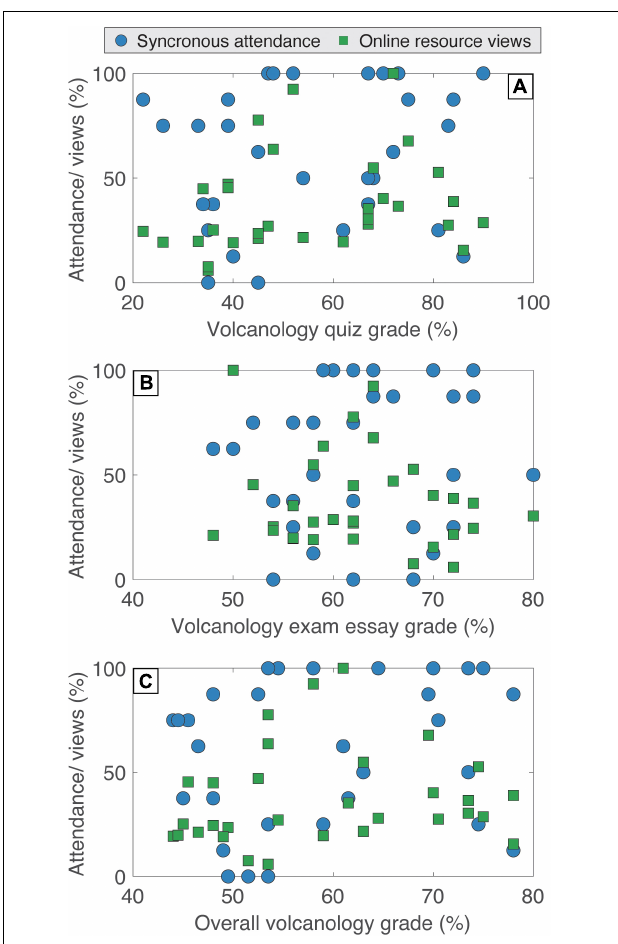
FIGURE 3 | Relationships between student attendance and performance. The blue circles represent synchronous attendance during online guest lectures, practical sessions, and Q&A sessions. The green squares represent the virtual learning environment page views, normalized to the maximum number of page views recorded for an individual student. No correlations between attendance and student grade (a measure of performance) are observed for any of the assessments. The figure panels show (A) the quiz grade, (B) the exam essay grade and (C) the overall volcanology